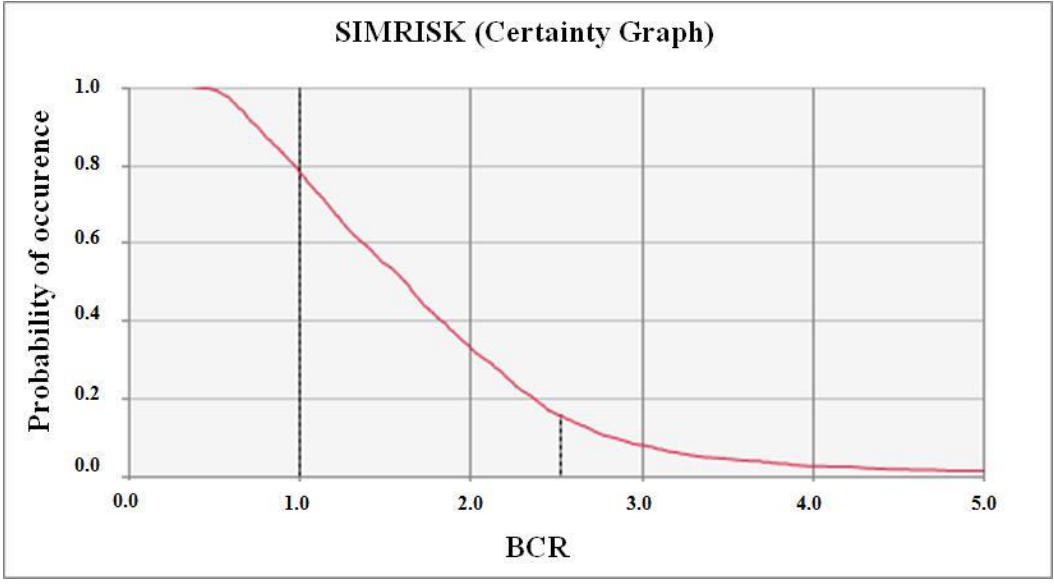
Figure 7. SIMRISK certainty graph result for the Nuuk airport